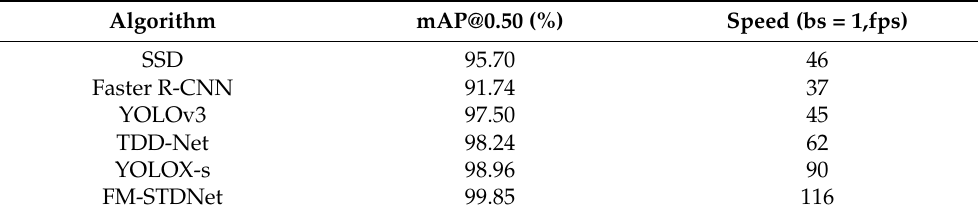
Table 3. Detection results of FM-STDNet and other 5 excellent